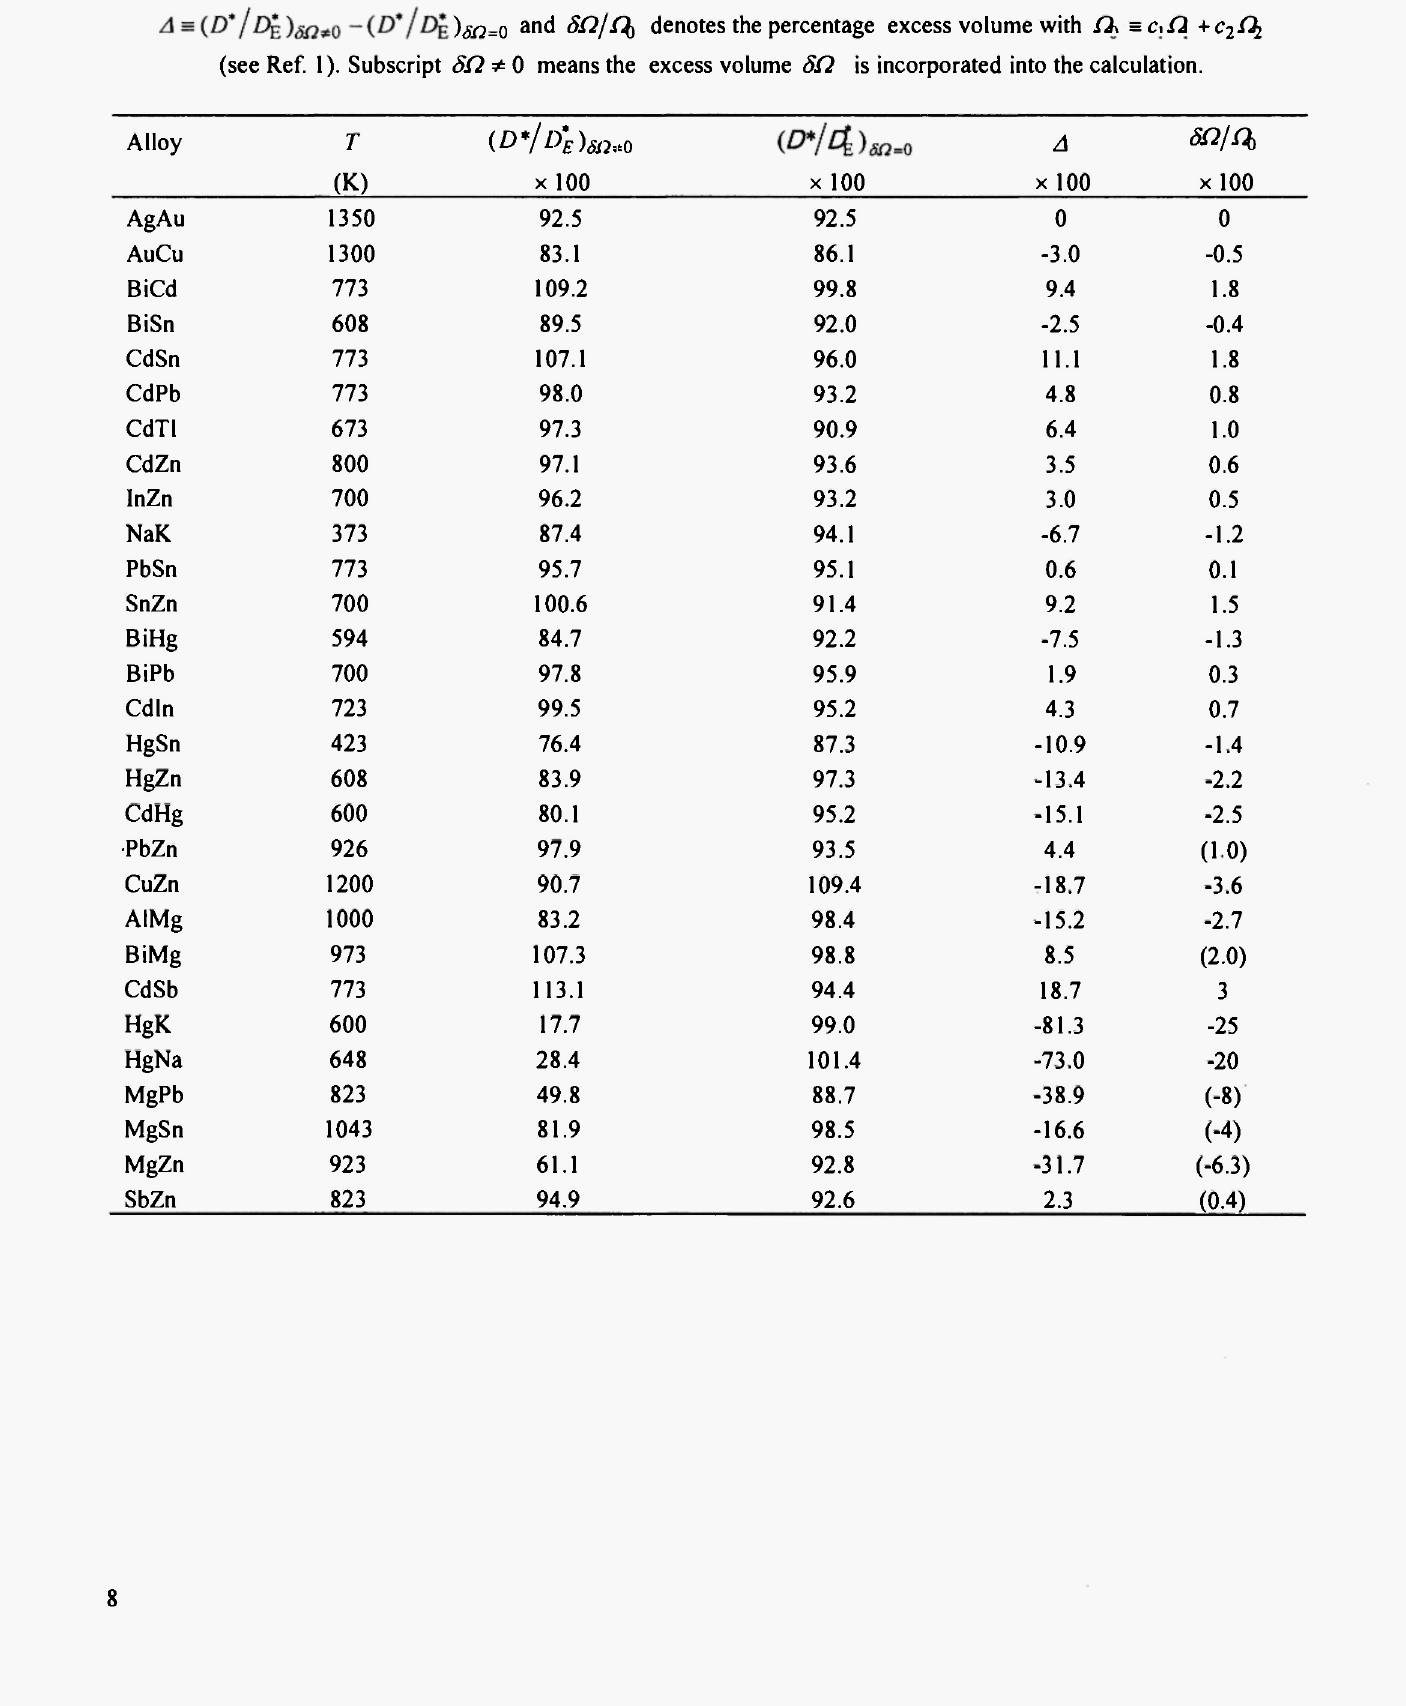
Relationship between Δ and δΩ/Q in the case ofc, = c 2 = 0.5, where Δ is defined